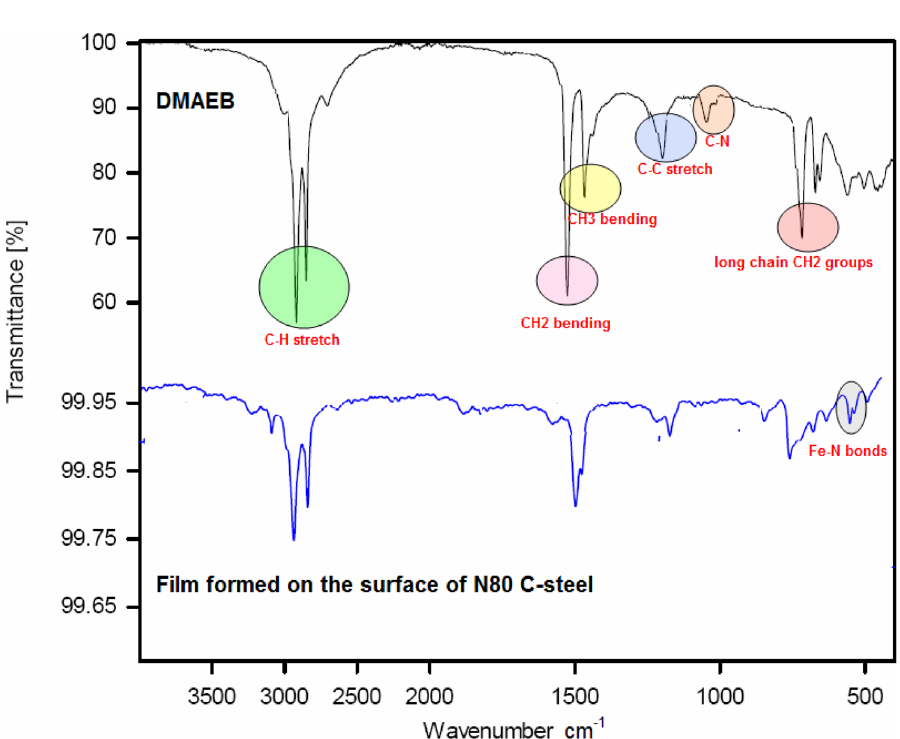
Figure 10. FT-IR spectra of pure DMAEB and film formed on the surface of N80 C-steel in the inhibited solution (15.0% HCl + 100 mg/l